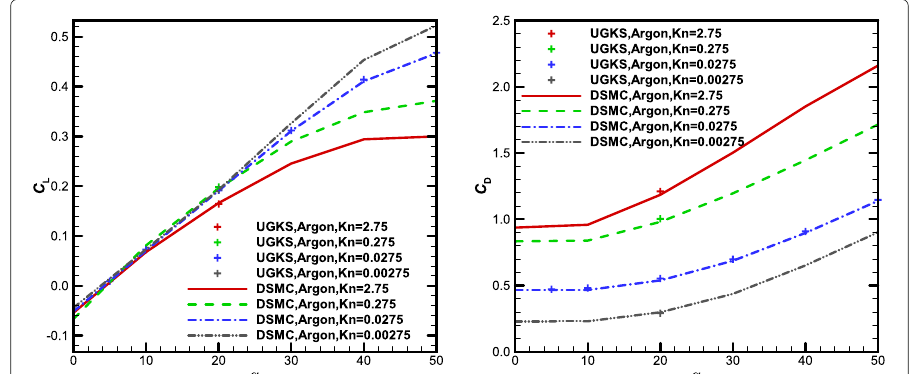
Fig. 8 Comparison of lift and drag coefficients vs angle of attack between DSMC and UGKS